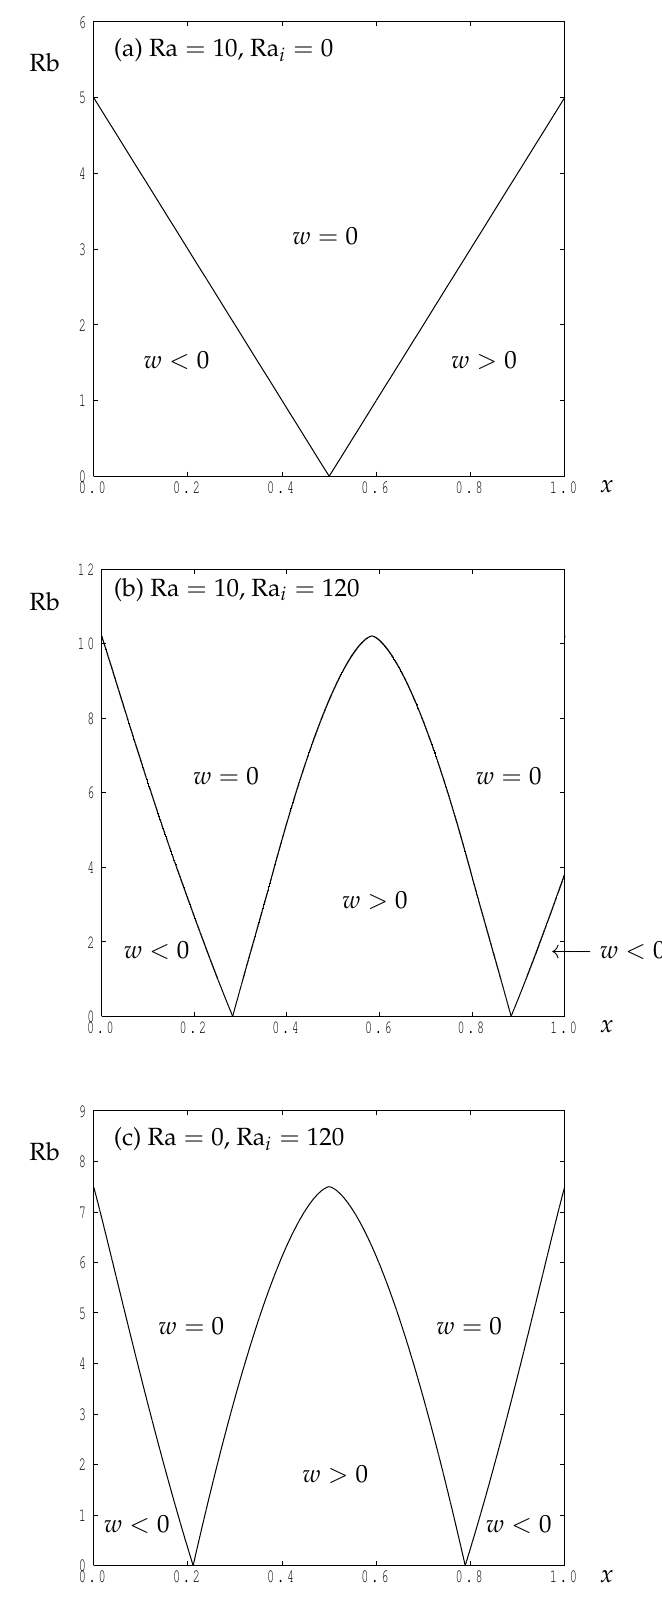
Figure 2. Displaying the evolution of the locations of the yield surfaces with Rb for three cases: ( a ) pure external heating, ( b ) a combination of internal and external heating and ( c ) pure internal heating. The corresponding values of Ra and Ra i are given in each